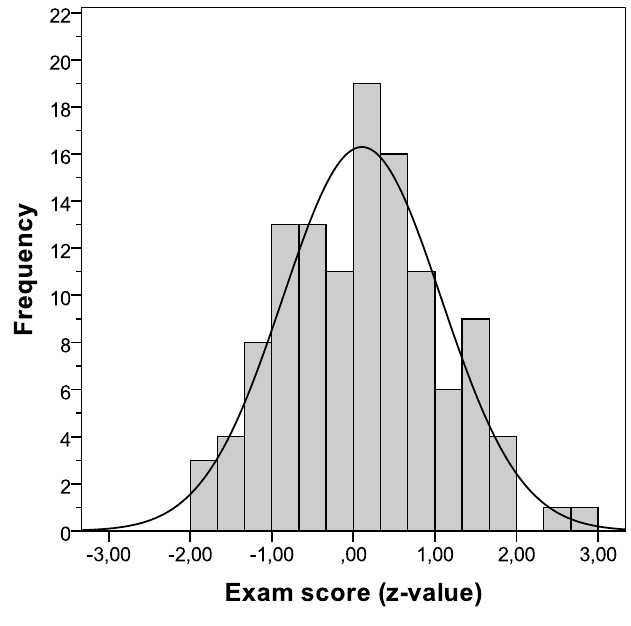
Fig. 3. Distribution of the exam